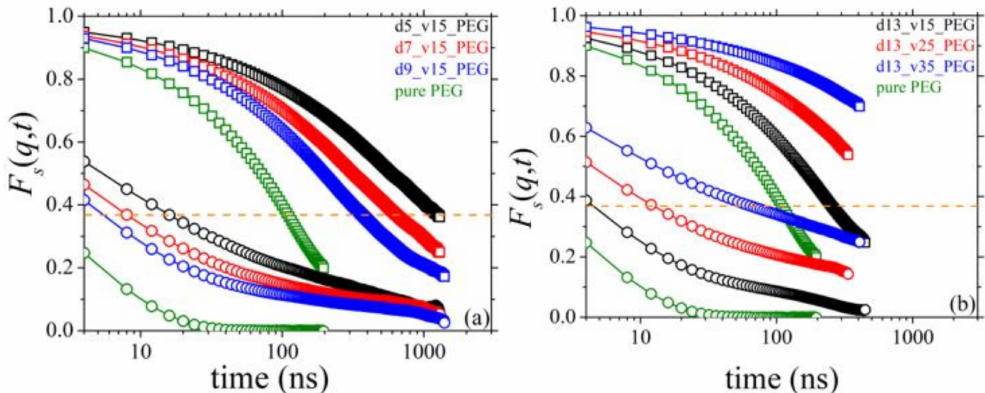
Figure 15. MD-predicted F s ( q , t )-vs.- t spectra ( T = 413 K and p = 1 atm) and dependence on: ( a ) silica size, and ( b ) silica concentration. Results are shown for q = 0.04 Å − 1 (open squares) and q = 0.15 Å − 1 (open circles). The orange dashed line indicates the value 1/ e of the self-intermediate scattering function (attained when time equals the characteristic relaxation